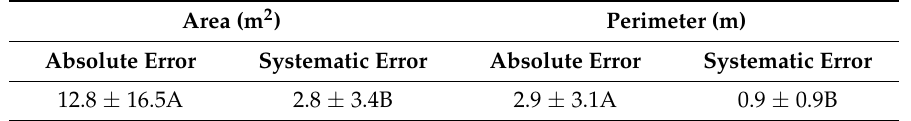
Table 1. Comparison of systematic error and absolute error of gully area and gully perimeter (mean ± SD).